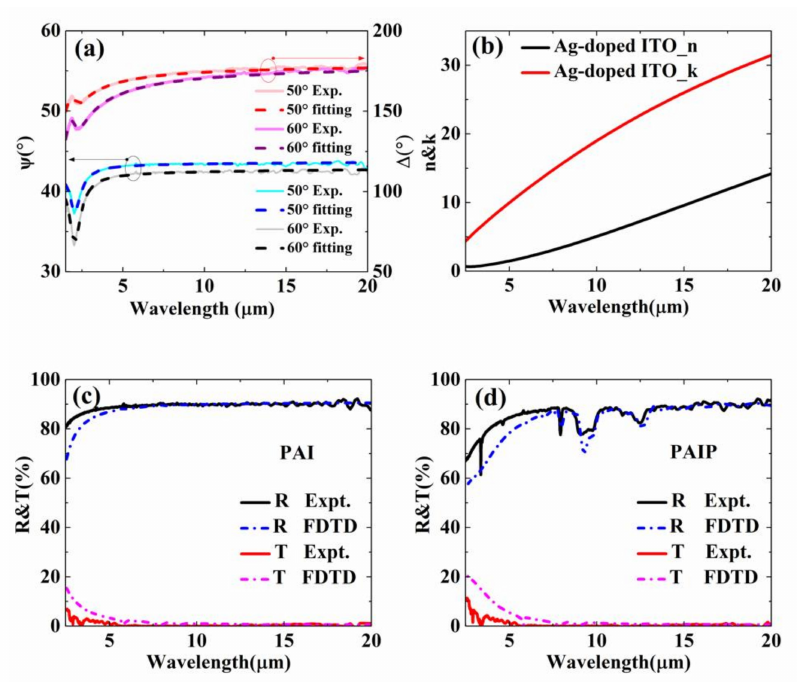
Figure 2. ( a ) Ellipsometry data Ψ and ∆ (solid curves) for a 65 nm thick Ag-doped ITO thin film in the spectral range of 3–20 µ m at incident angles θ = 50 ◦ , 60 ◦ . ( b ) Optical constant of Ag-doped ITO. ( c ) Reflection and transmission spectrum of the PAI sample. ( d ) Reflection and transmission spectrum of the PAIP sample.